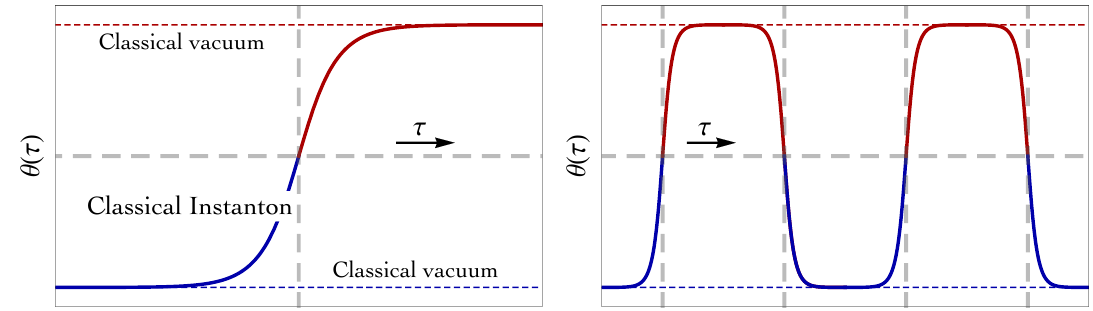
Figure 2 . Axion (cid:12)eld pro(cid:12)le corresponding to the wormhole solution. The blue and red colors describe the instanton and anti-instanton part of the solution (see (cid:12)gure 1). A string of widely sep- arated instantons and anti-instantons (right panel) provides an approximate stationary point of the Euclidean action (which becomes an exact solution of the equation of motion only asymptotically, in the limit of in(cid:12)nite